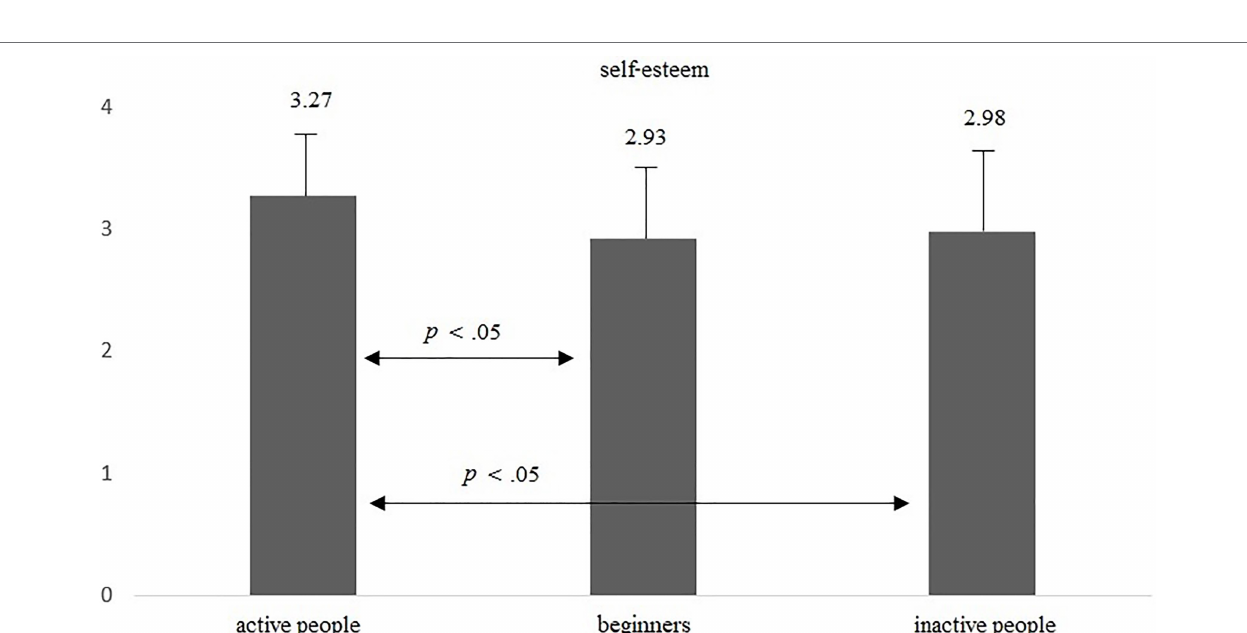
FIGURE 3 | Average level of self-esteem in groups of active people, beginners, and inactive